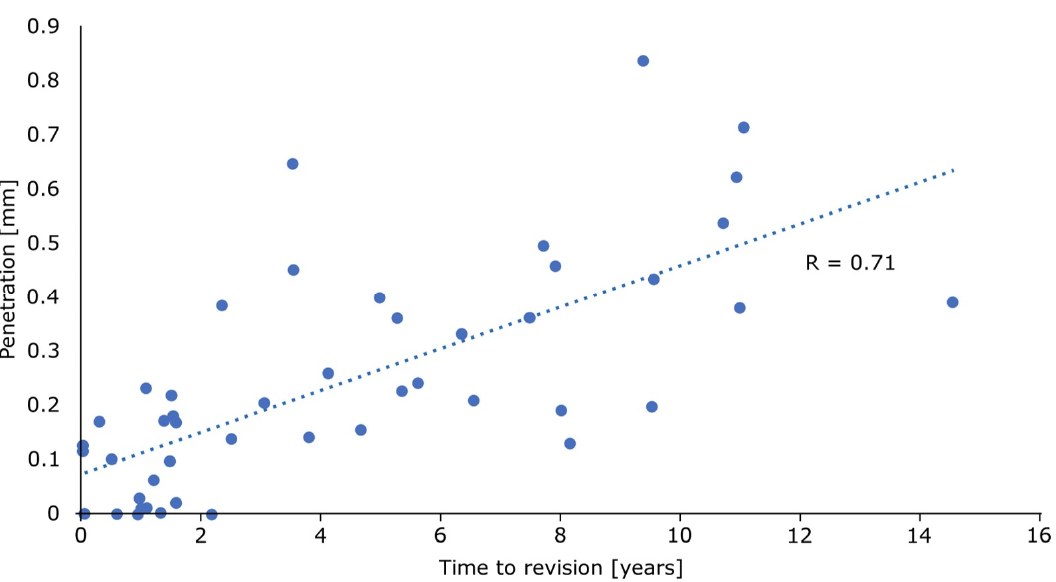
Figure 6. There is a strong correlation between the time to revision and penetration (R = 0.71; p < 0.001; n = 47).